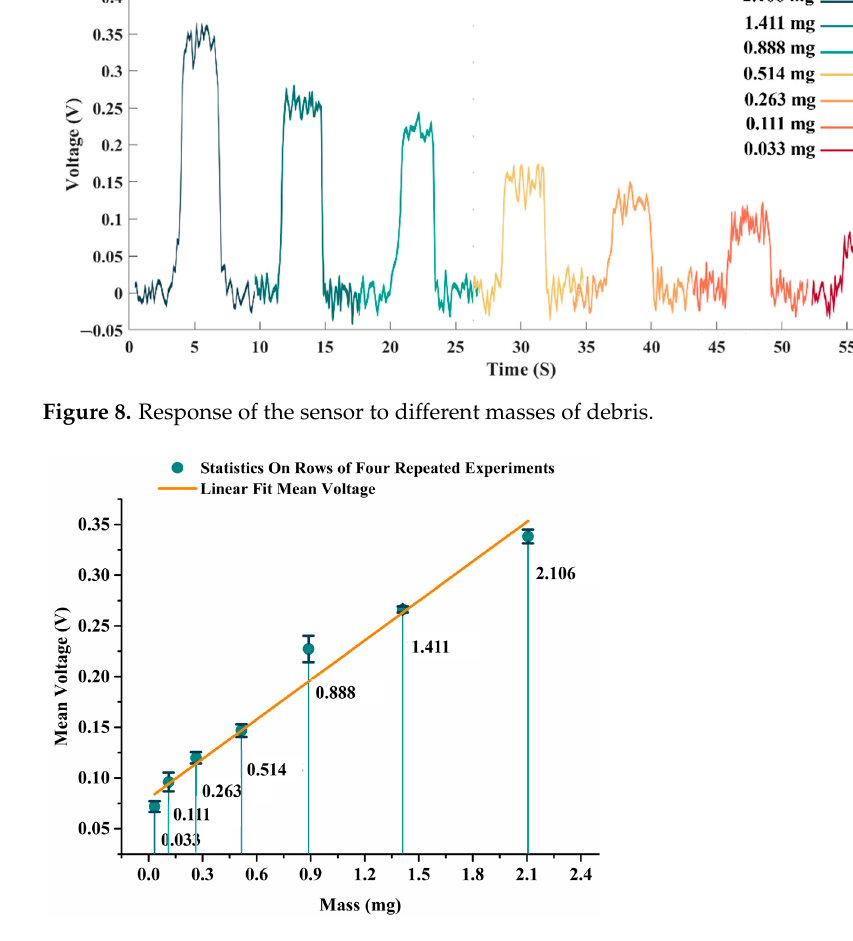
Figure 9. Output voltages of the sensor. Each error bar is derived from the data of six replicate